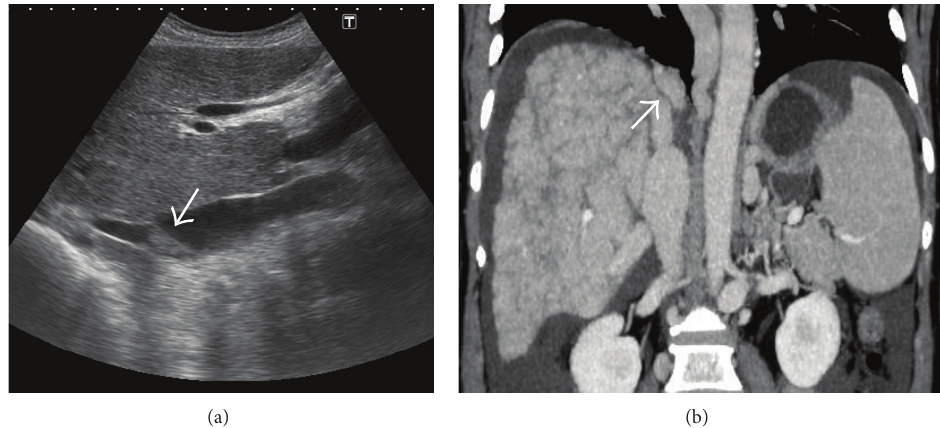
Figure 18: Gray-scale US (a) and coronal MIP (b) images demonstrating an IVC web (sequel of chronic focal thrombosis) which appears as a linear echogenic structure on US (arrow in (a)), while on CT, it appears as an intraluminal hypodense linear structure (arrow in